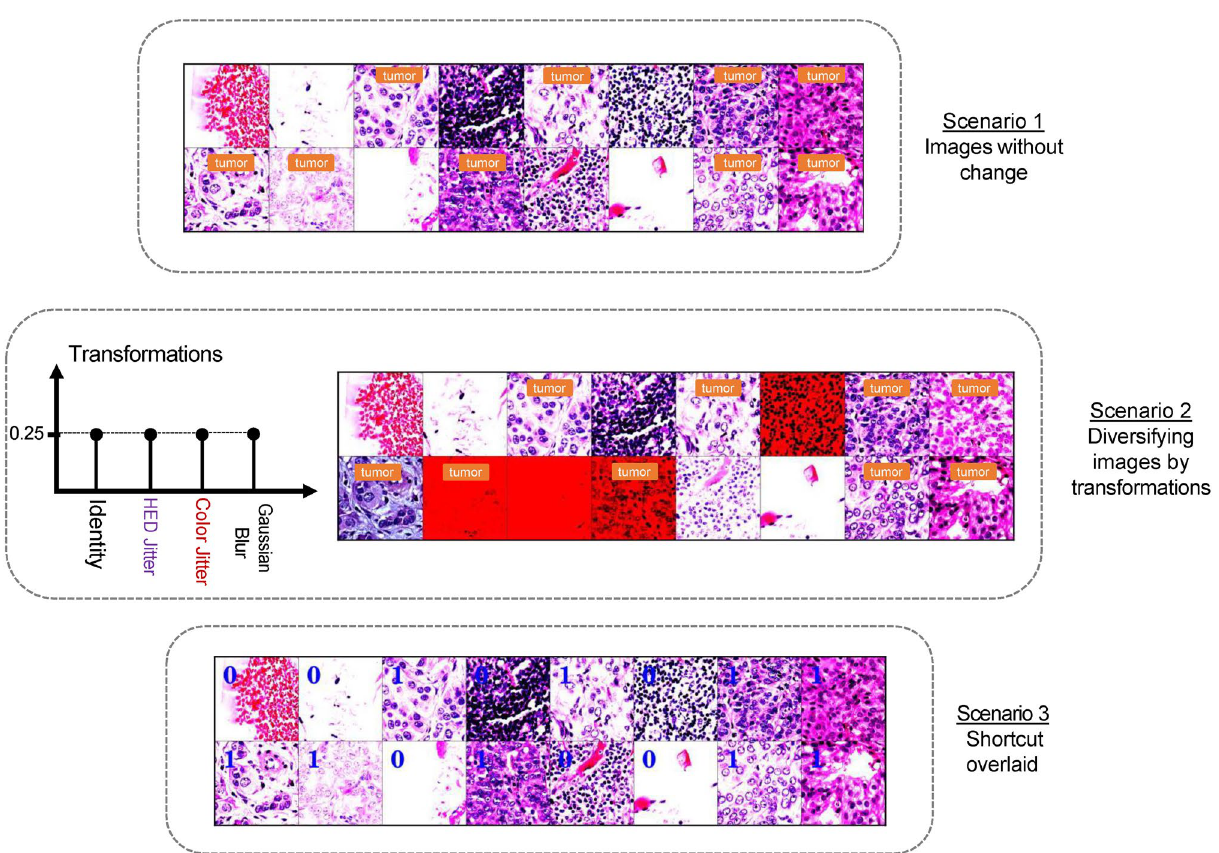
Figure 2. A sample training batch for different scenarios. Note that the patches in scenario 1 train sets did not undergo any augmentation. As it can be seen, among identity , HED jitter , color jitter , and Gaussian blurring transformations with uniform distribution ( p = 0 . 25), in scenario 2 , one transformation is picked for each image in the batch. In scenario 3 , the correct label (0: non-tumor, 1: tumor) of each image is overlaid on the image